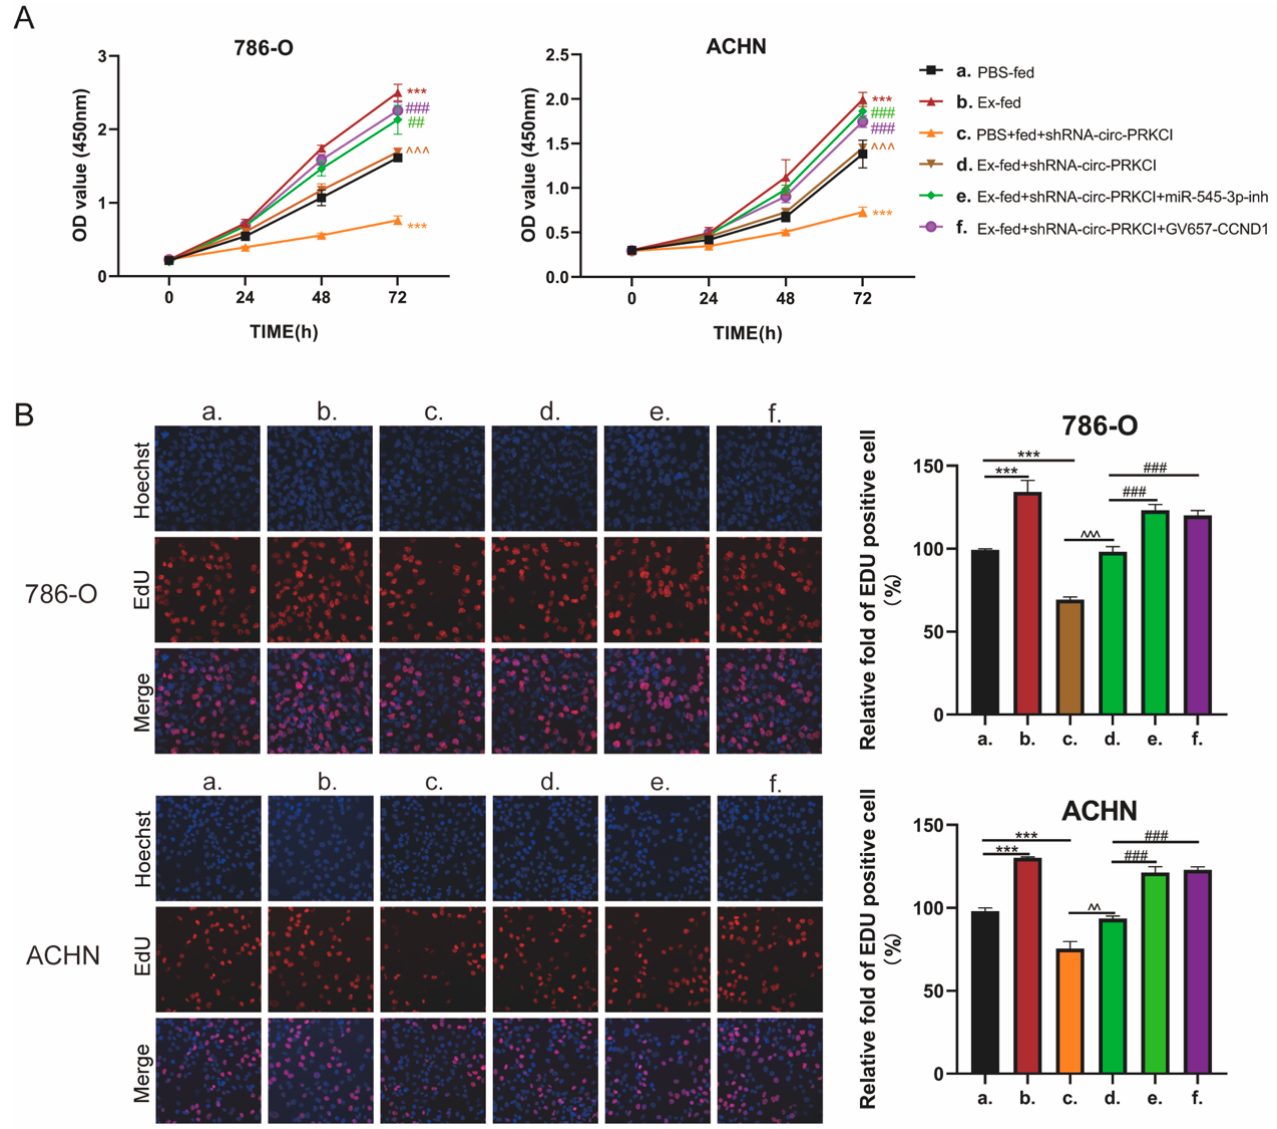
Figure 7. circ-PRCKI promoted cell proliferation by regulating the miR-545-3p/CCND1 axis. ( A ) Cell proliferation of 786-O and ACHN cells treated with (a) PBS; (b) Caki-1-derived exosomes; (c) PBS plus circ-PRKCI shRNA (shRNA-circ-ORKCI); (d) Caki-1-derived exosomes plus shRNA-circ-PRKCI; (e) Caki-1-derived exosomes and shRNA-circ-PRKCI plus miR-545-3p inhibitor (miR-545-3p-inh); (f) Caki-1-derived exosomes and shRNA-circ-PRKCI plus GV657-CCND1, as detected by CCK8 assay. ( B ) EdU assay for proliferation ability of 786-O and ACHN after the indicated treatment. (*** p < 0.001, compared to PBS-fed group; ˆˆ p < 0.05, ˆˆˆ p < 0.001, compared to shRNA-circ-PRKCI group; ## p < 0.05, ### p < 0.001, compared to Ex-fed+shRNA-circ-PRKCI